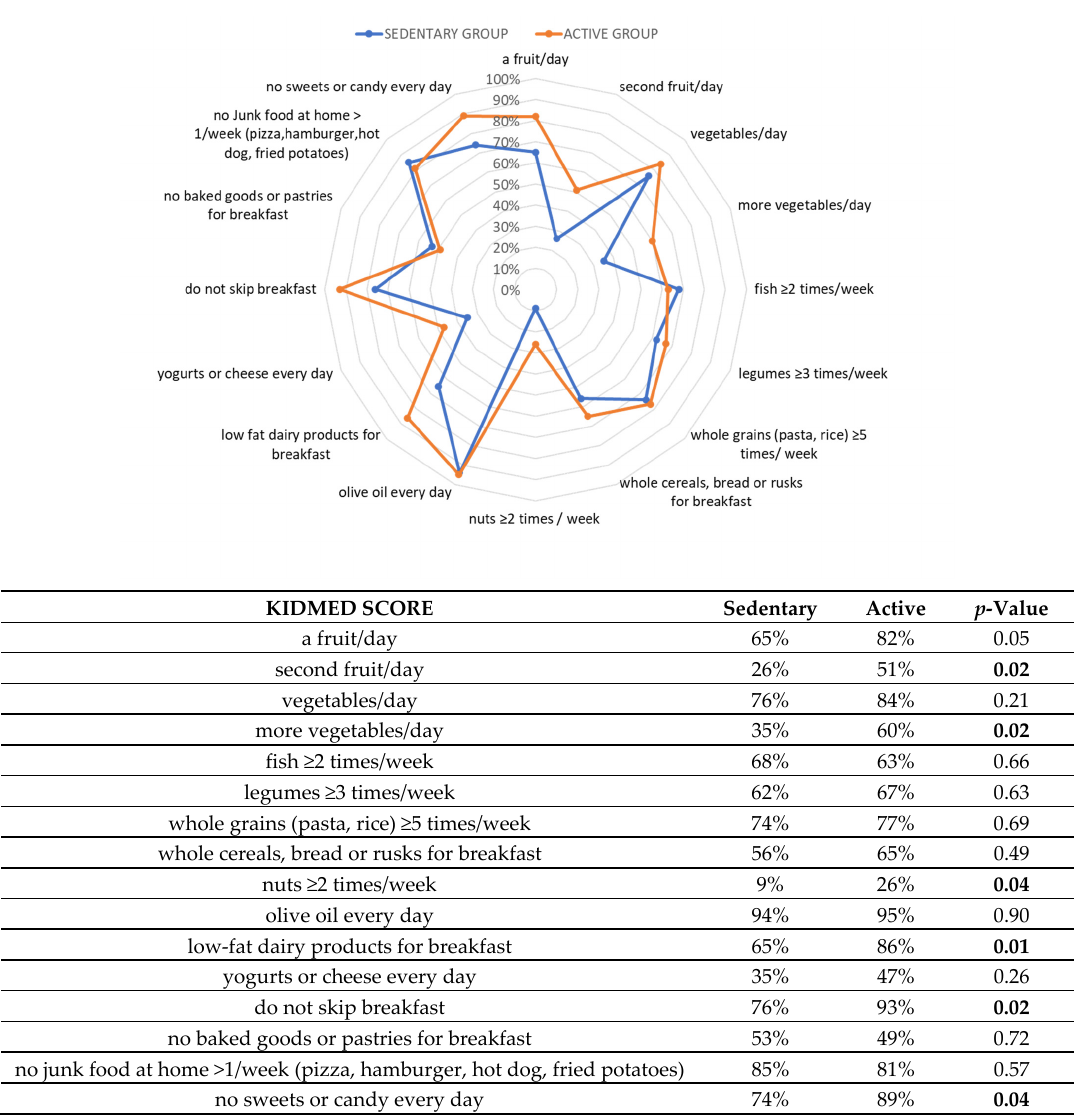
Figure 1. Compliance with items from the KIDMED test in active and sedentary adolescents. The radar chart plots the values of each item of the Mediterranean diet score along a separate axis that starts in the center of the chart (0% compliance) and ends at the outer ring (100% compliance). In the table the statistical differences of each item of the Mediterranean diet score between active and sedentary adolescents were evaluated by chi-squared tests.